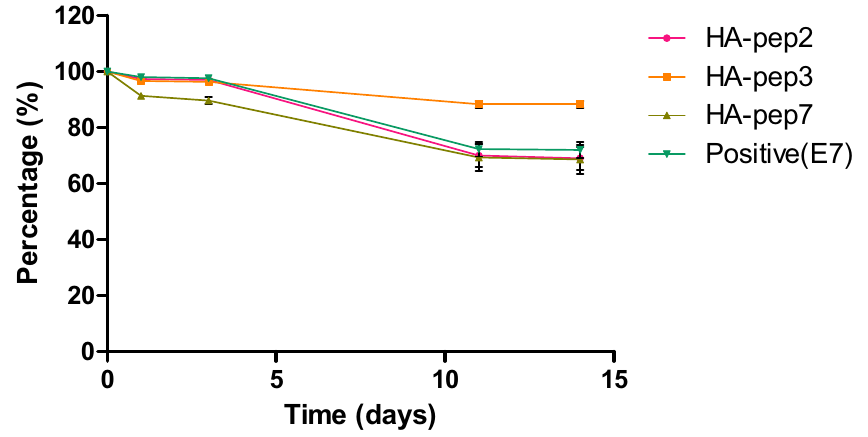
Figure 4. Release kinetics of HA-binding peptides and positive peptide (E7) on hydroxyapatite.